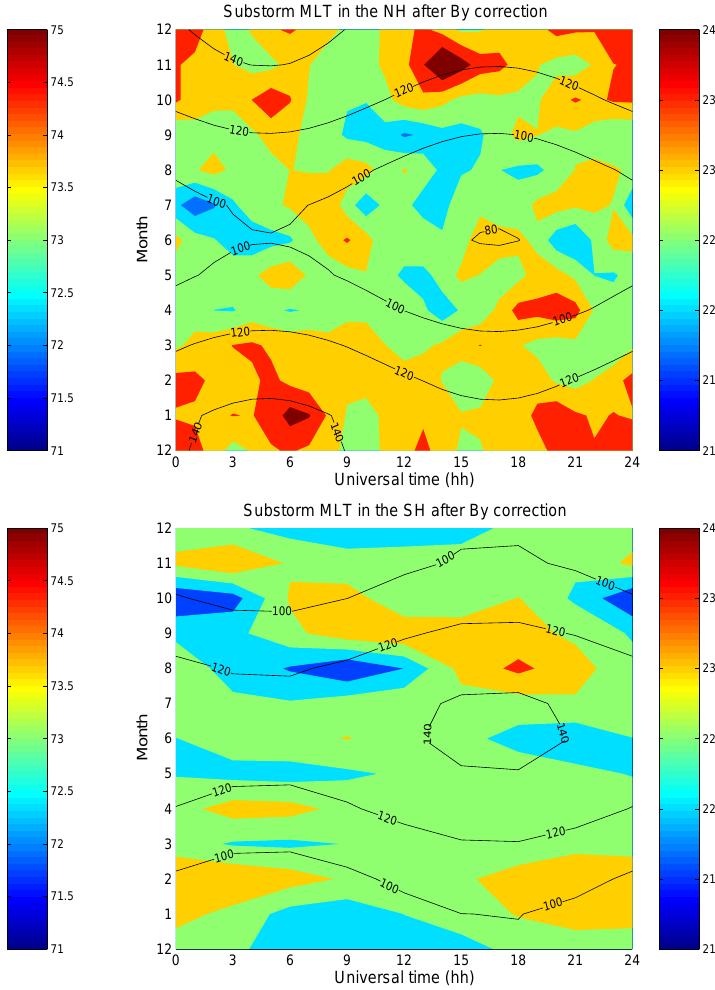
Fig. 8. Same as Fig. 6, but after removal of the E m effect (see text). Fig. 9. Same as Fig. 7, but after removal of the IMF B y effect (see